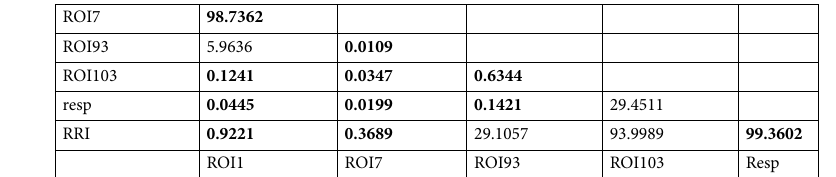
Table 2. Significance of differences of flows from structures marked below the columns to the ones marked at the left of the rows. The numbers show percentiles of the distributions obtained by the bootstrap approach (see 16,17 ) for the high anxiety group in the 0.2–0.4 Hz band. Significant differences (marked by bold numbers) are those, which exceed the range of 95% of the random distribution of the differences obtained by the bootstrap method. Depending on the sign of the differences between in- and outflows, they are located below the 2.5 and above the 97.5